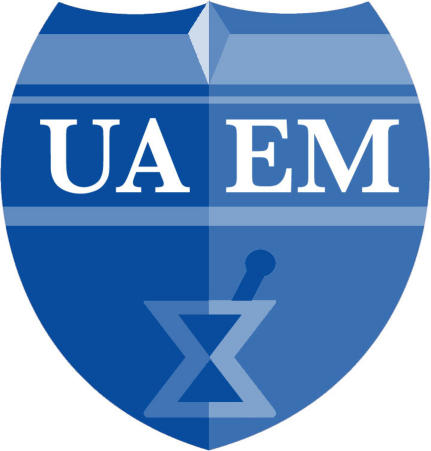
Logo of Universities Allied for Essential Medicines(Image: UAEM)